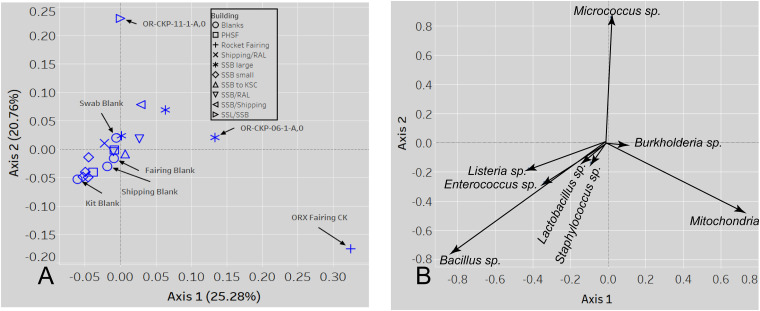
A PCOA plot of the weighted UNIFRAC beta diversity metric (A) shows that samples 11 and the fairing CK sample are outliers. Samples are colored by location A biplot (B) shows which sOTUs/organisms affect the distribution of the data. The length of the arrow is proportional to the strength of the effect.